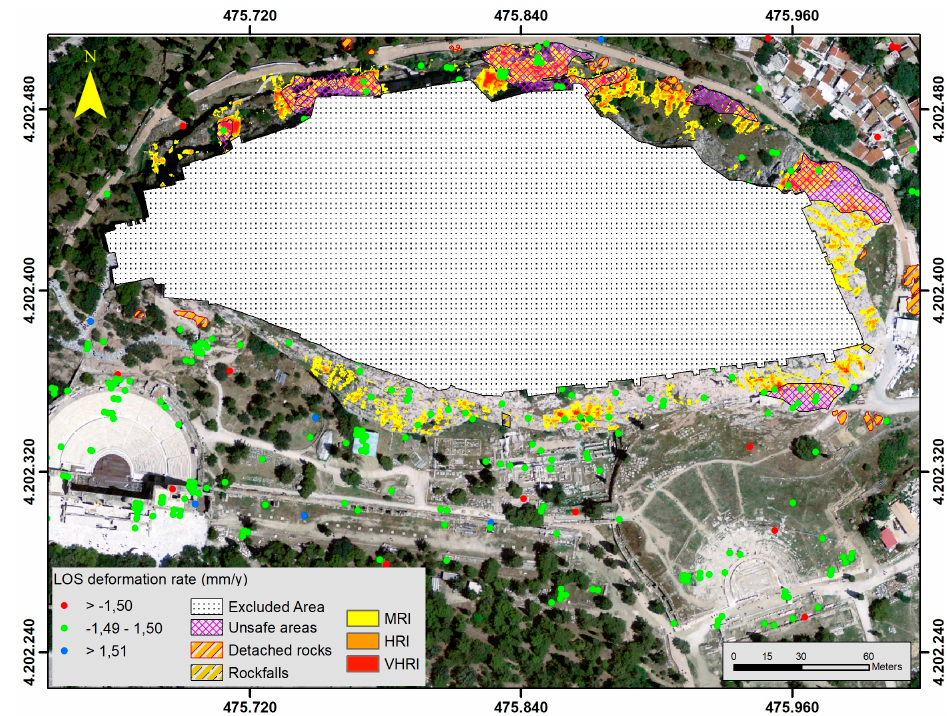
Figure 14. Rock Instability Index—Satellite data Analysis.